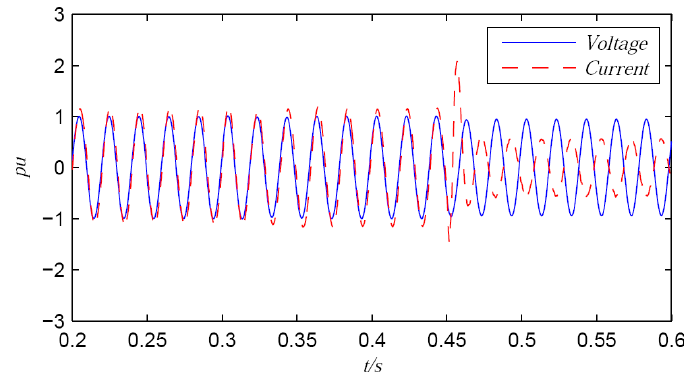
Figure 5. Single-phase voltage and current output. Figure 5. Single ‐ phase voltage and current output. Figure 5. Single ‐ phase voltage and current output.